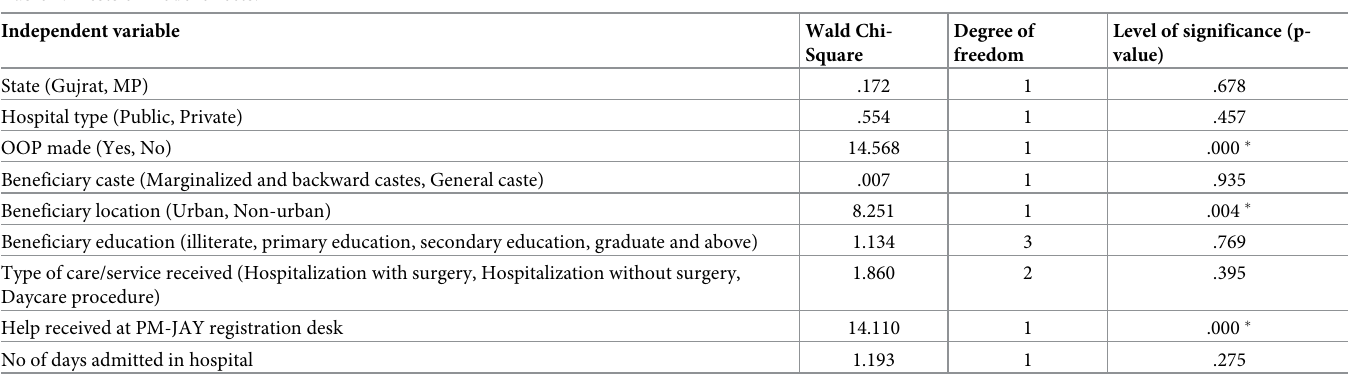
Table 4. Tests of model effects.